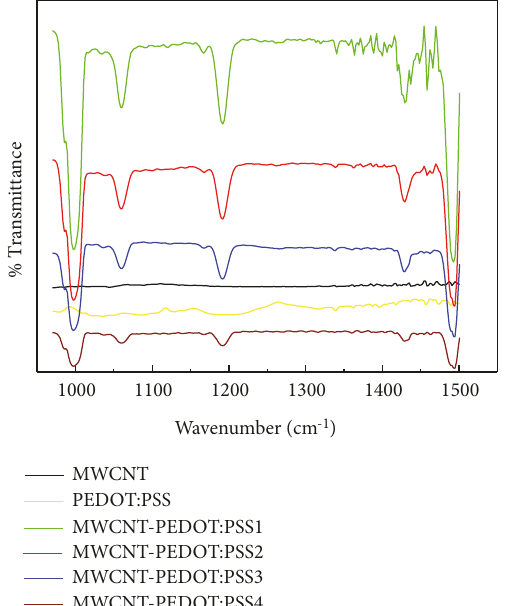
Figure 6: FTIR of MWCNT, PEDOT:PSS and MWCNT-PEDOT: PSS films; MWCNT-PEDOT:PSS1-0.025wt% MWCNT, MWCNT- PEDOT:PSS2-0.05wt% MWCNT, MWCNT-PEDOT:PSS3-0.075wt% MWCNT, MWCNT-PEDOT:PSS4-0.1wt% MWCNT.